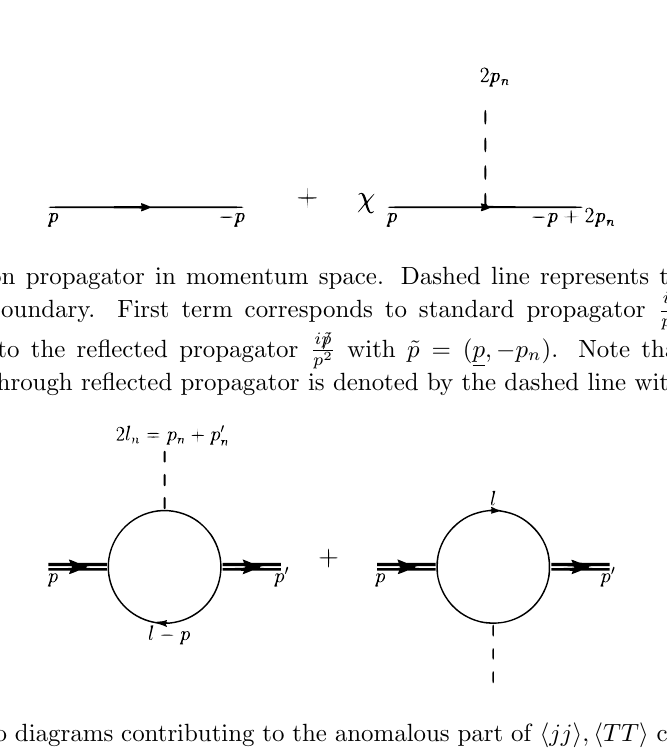
Figure 2 . The two diagrams contributing to the anomalous part of h jj i ; h TT i correlators. Double lines at the edges represent operator insertions with relevant vertices de(cid:12)ned in (4.7), (4.13). The perpendicular loop momentum is (cid:12)xed via (cid:14) ( (cid:0) 2 l n + p n + p 0 n